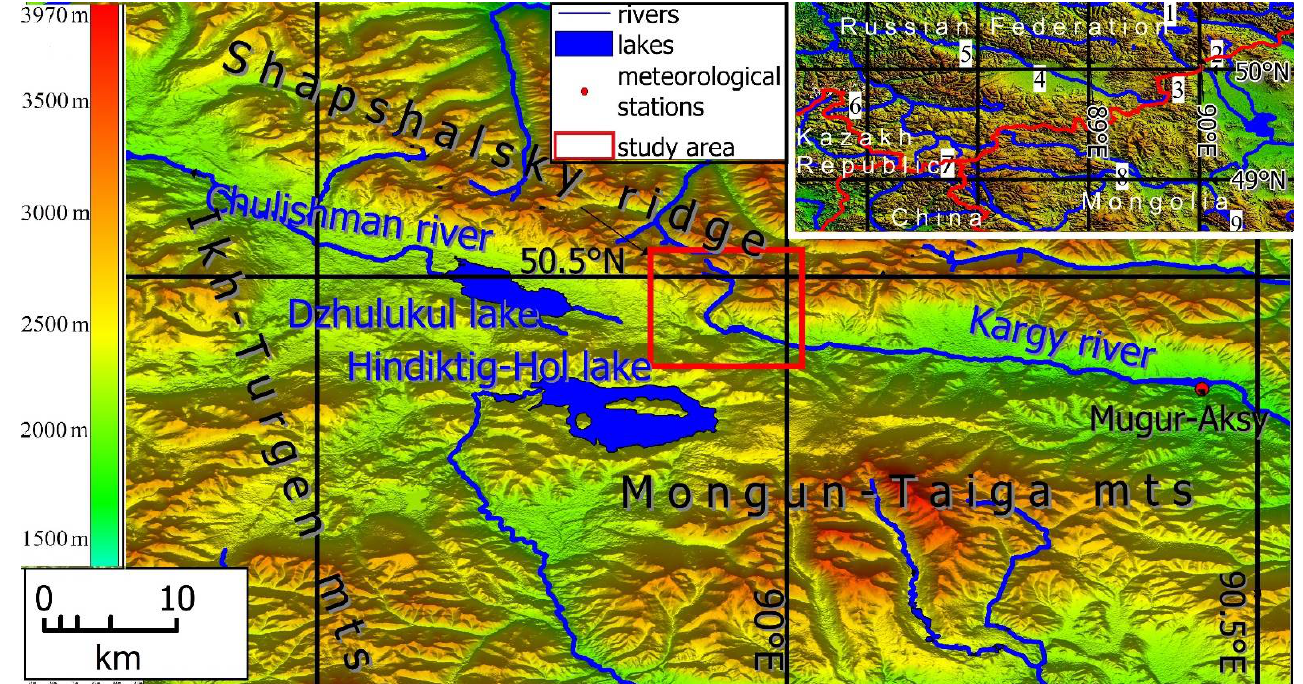
Figure 1. Location of the study area. Inset: 1—Dzhulukulskaya depression, 2—Mongun-Taiga, 3—Ikh-Turgen, 4—Chuya depression, 5—Kuray depression, 6—Uimon Basin, 7—Kanas valley, 8—Kobdo depression, and 9—Tsambagarav. Elevation is given on the basis of semitransparent digital elevation model SRTM [64].